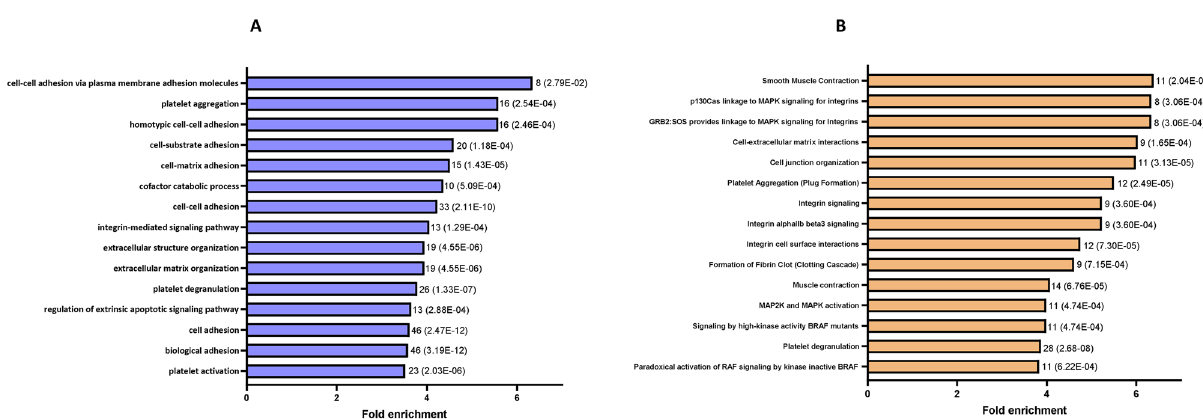
Figure 4. Functional annotation enrichment analysis of the differentially expressed proteins found in fragile X PBMCs total proteome. The number of proteins associated and corresponding FDR for each annotation are represented beside the bar. ( A ) The top 15 gene ontology biological process annotations ranked by the fold enrichment. ( B ) The top 15 REACTOME annotations ranked by the fold